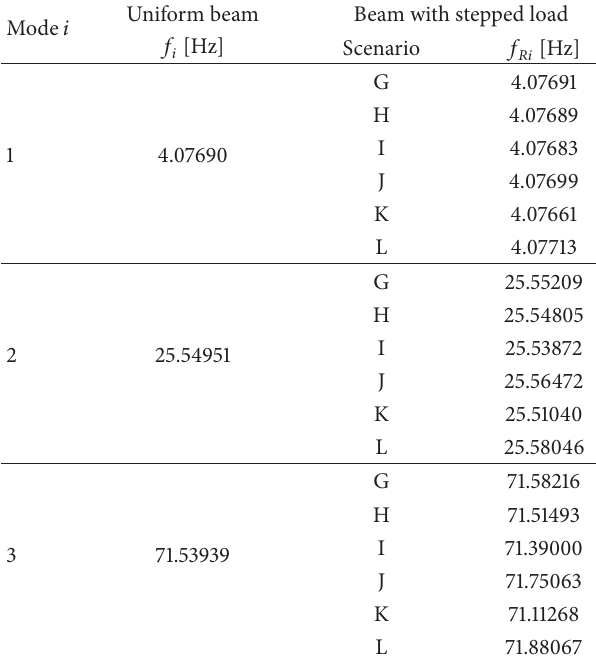
Table 7: The relative frequency shifts for large affected region